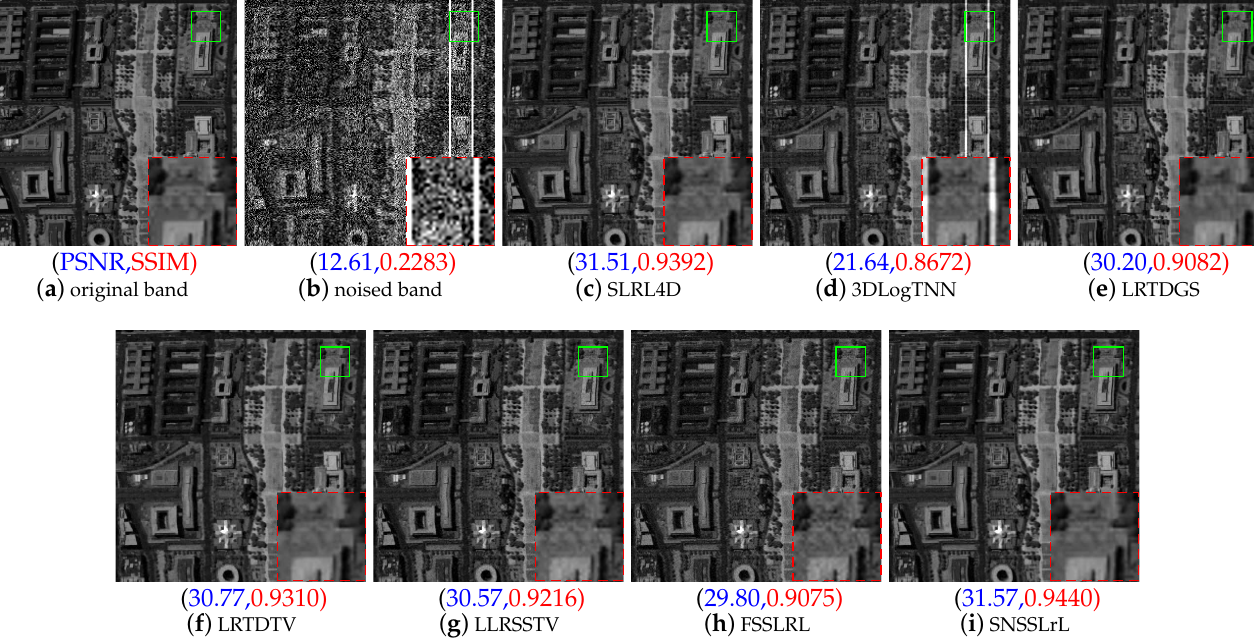
Figure 4. Band image on spectral band 117 of WDC dataset under simulated case 4. ( a ) Original band; ( b ) Noised band; ( c ) SLRL4D; ( d ) 3DLogTNN; ( e ) LRTDGS; ( f ) LRTDTV; ( g ) LLRSSTV; ( h ) FSSLRL; ( i )